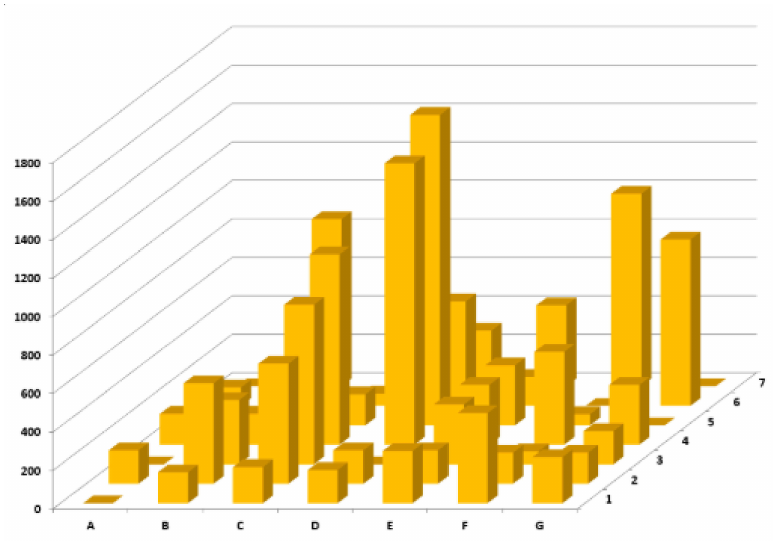
Figure 12. Graph of differences in measured velocities [m · s − 1 ] of ultrasound wave for specimen A2_3 before and after blast load of 600 g TNT.